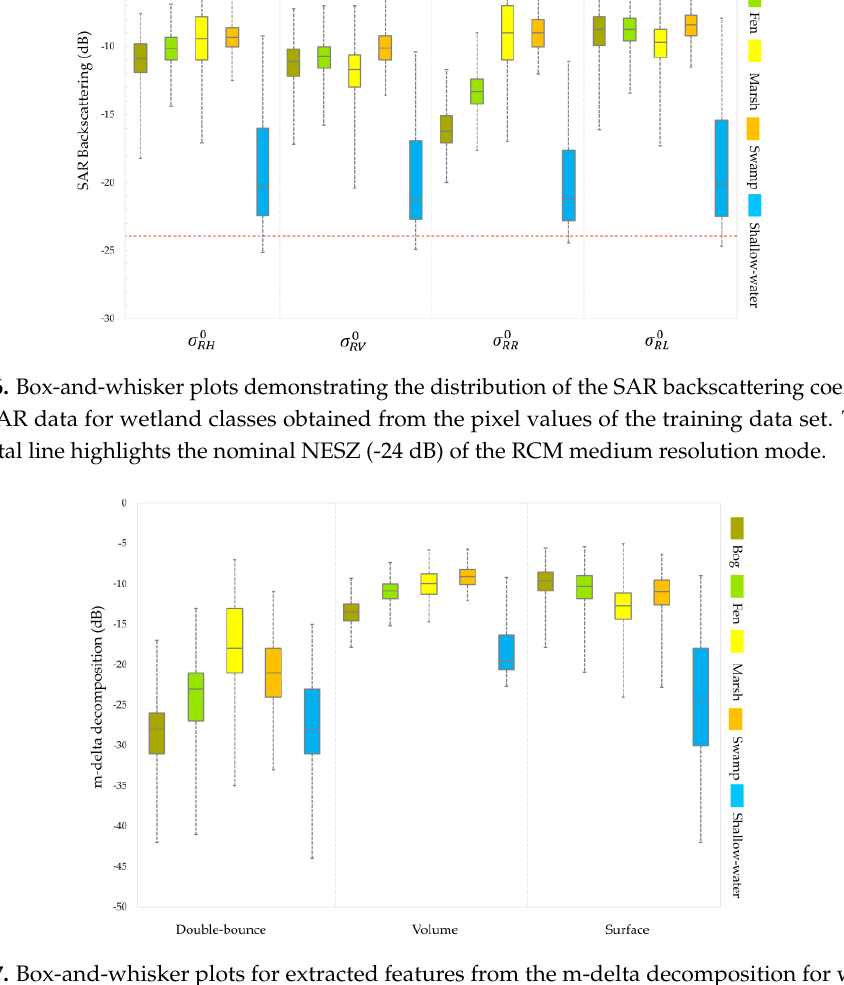
Figure 7. Box-and-whisker plots for extracted features from the m-delta decomposition for wetland classes obtained from the pixel values of the training data set.